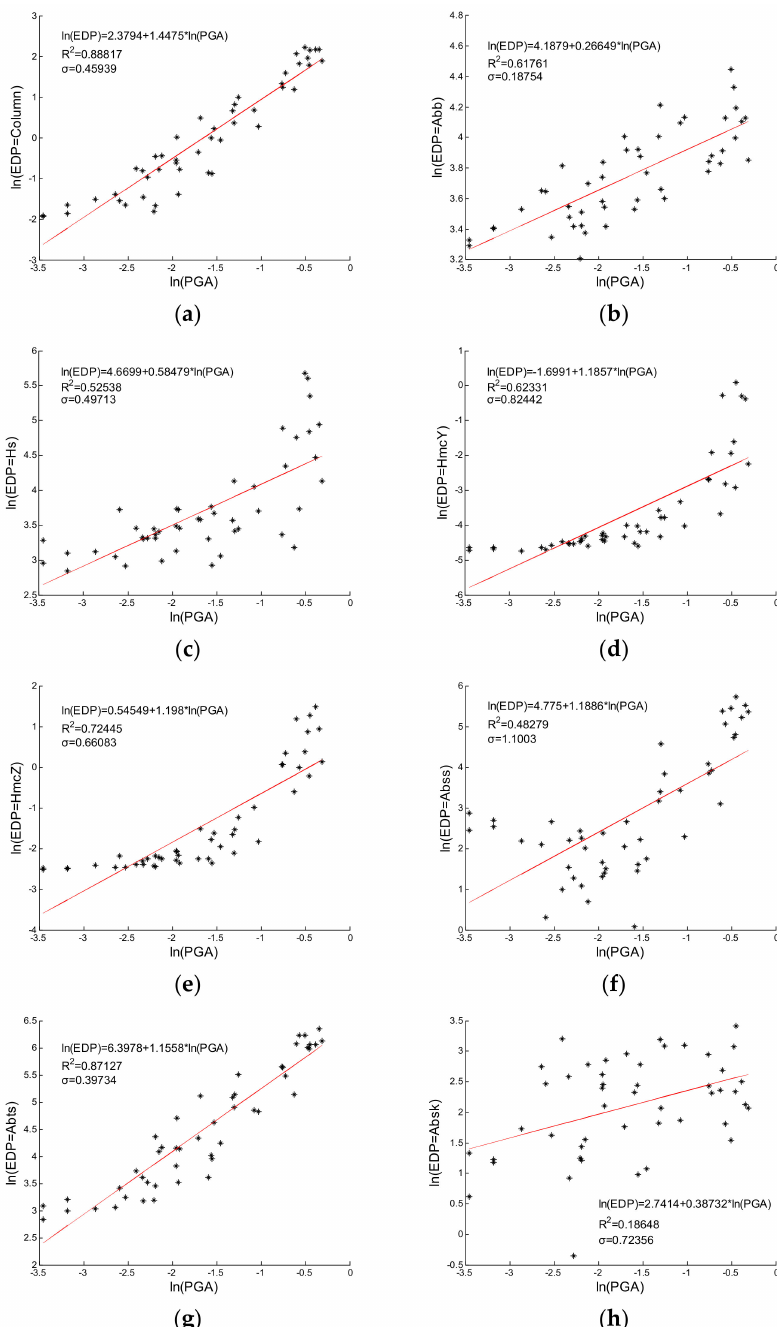
Figure 4. Regression analyses of seismic demands for ( a ) Column; ( b ) Abb; ( c ) Hs; ( d ) HmcY; ( e ) HmcZ; ( f ) Abss; ( g ) Abts; ( h ) Absk. The higher R 2 value signifies the stronger linear relationship and the lower dispersion between the variables of interest [23]. Consequently, obviously seen in Table 2, the linear relationships between the engineering demand parameter (EDP) of components including Column, Abb, HmcY, HmcZ, Abts and the ground motion intensity PGA in logarithmic space are strong, and the dispersion are low. The minimum R 2 value corresponding to the component of Absk, with the value of 0.187, is acceptable compared with the minimum R 2 value of 0.18 from the study of DesRoches et al.